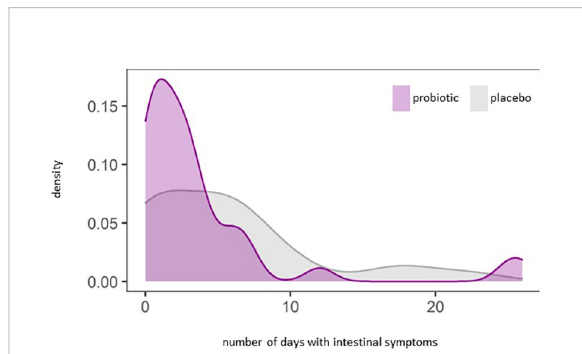
FIGURE 6 Density plot analysis of general intestinal symptoms (abdominal pain, bloating, heartburn, nausea, vomiting, diarrhea, constipation)